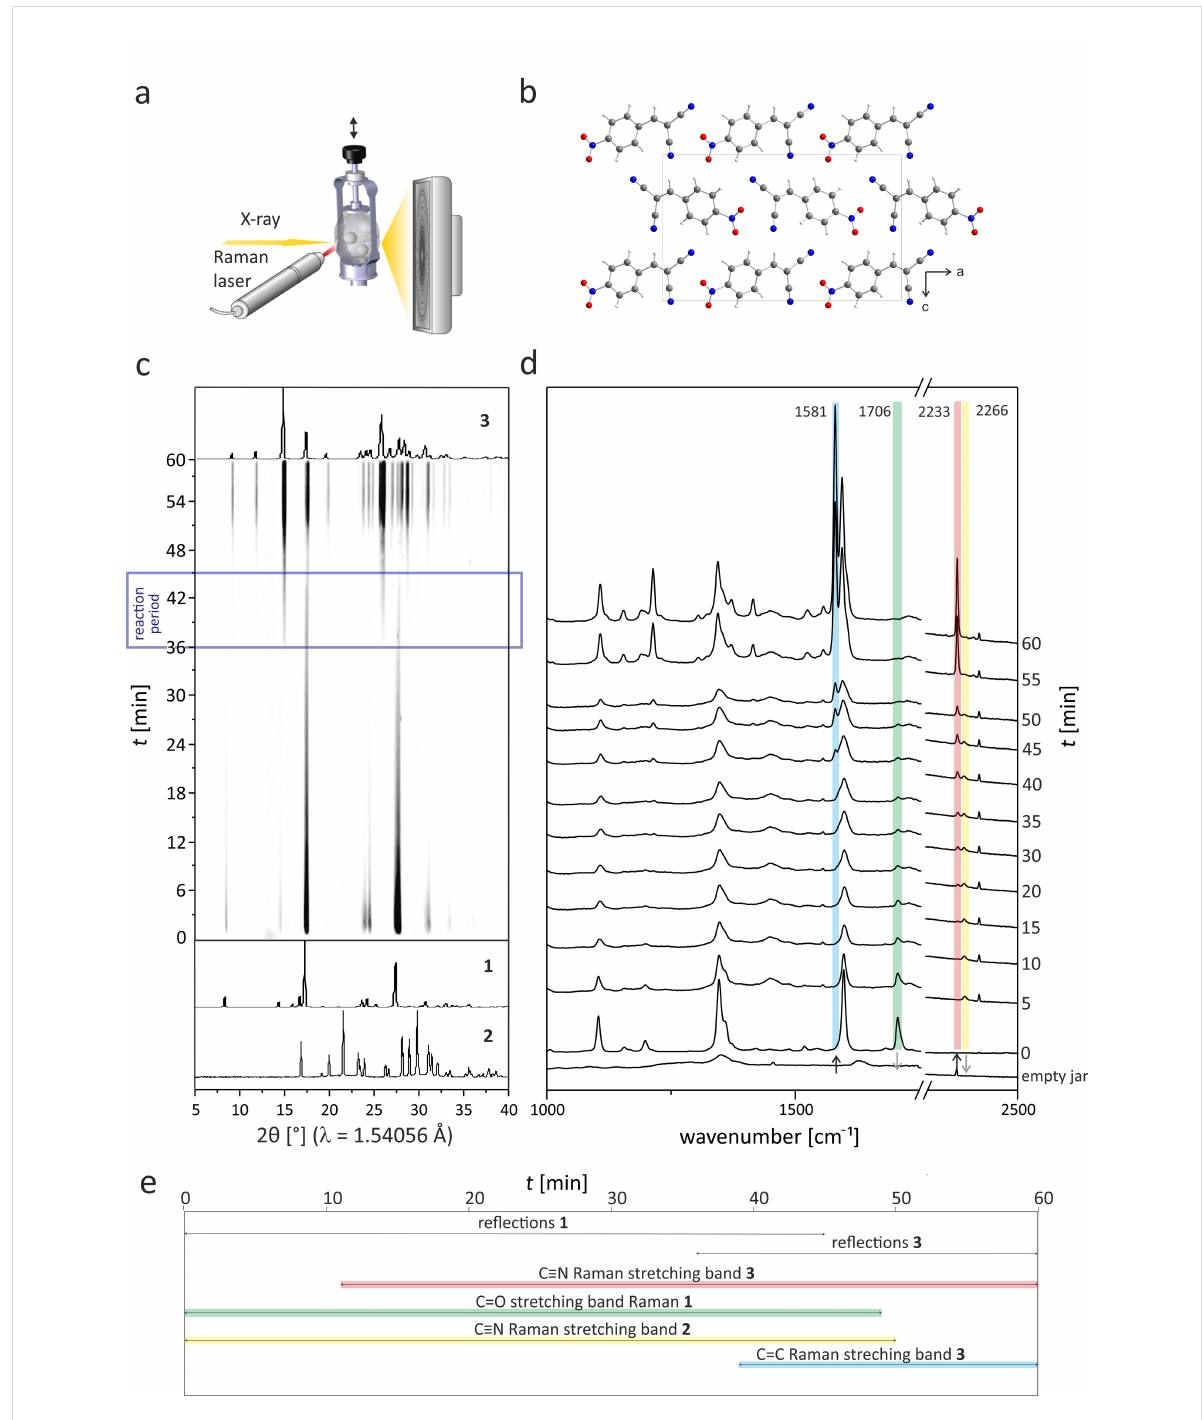
Figure 2: a) Schematic diagram of the in situ setup for investigating mechanochemical reactions in a tandem approach based on synchrotron X-ray powder diffraction and Raman spectroscopy. b) Crystal structure of the final product p -nitrobenzylidenemalononitrile ( 3 ) along the b -axis. c) Time- resolved X-ray diffraction patterns recorded during the Knoevenagel condensation of p -nitrobenzaldehyde with malononitrile yielding 3 . Three phases can be distinguished based on the XRPD data. During the first 36 minutes, the reflections of the reactant 1 are observed. Within a time-span of nine minutes, the product is formed, evident from two strong reflections at 2 θ = 14.6° and 25.7°. d) Time-resolved Raman spectra measured simultaneous- ly (Here, the Raman spectra are shown with a 5 min interval. The complete set of spectra is shown in Supporting Information File 1, Figure S1.) The progress of the reaction can be detected from the decreasing signal of the C=O stretching band of 1 at 1706 cm − 1 (green) and the increasing signal of the C=C stretching band at 1581 cm − 1 (blue). The band attributed to the C ≡ N stretching shifts from 2266 cm − 1 (yellow) in 2 to 2233 cm − 1 (red) in the product. The first Raman spectrum shows the contribution of the empty jar. e) Course of the reaction detected by XRPD and Raman